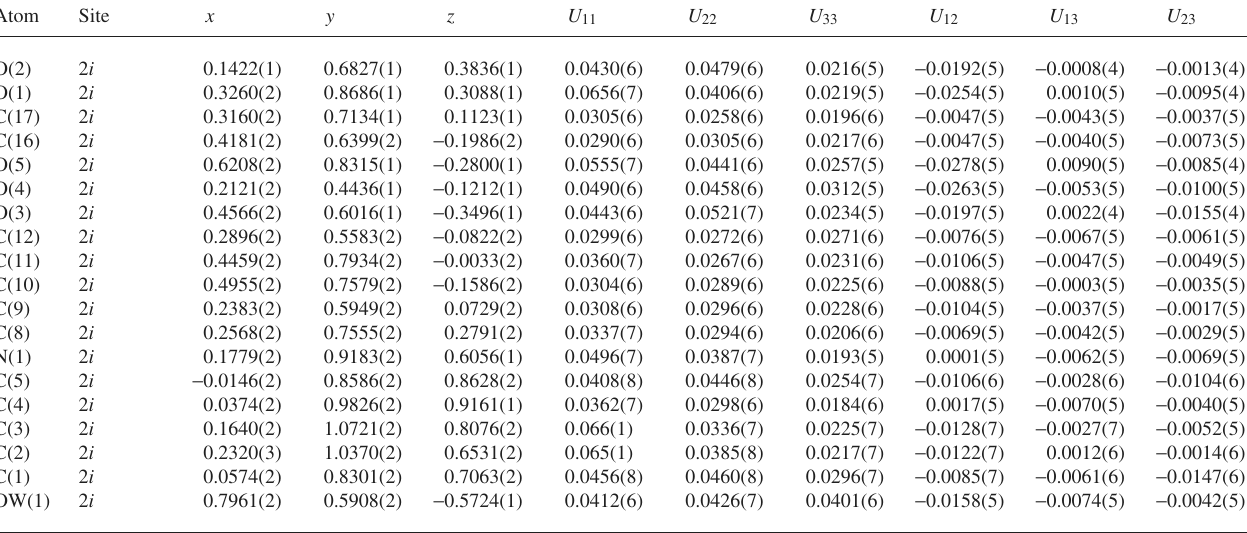
Table 3. Atomic coordinates and displacement parameters (in Å 2 )